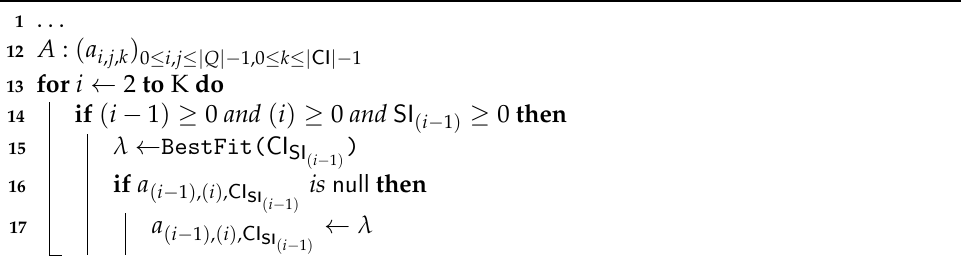
Algorithm 2: Outliers removal (extension of Algorithm